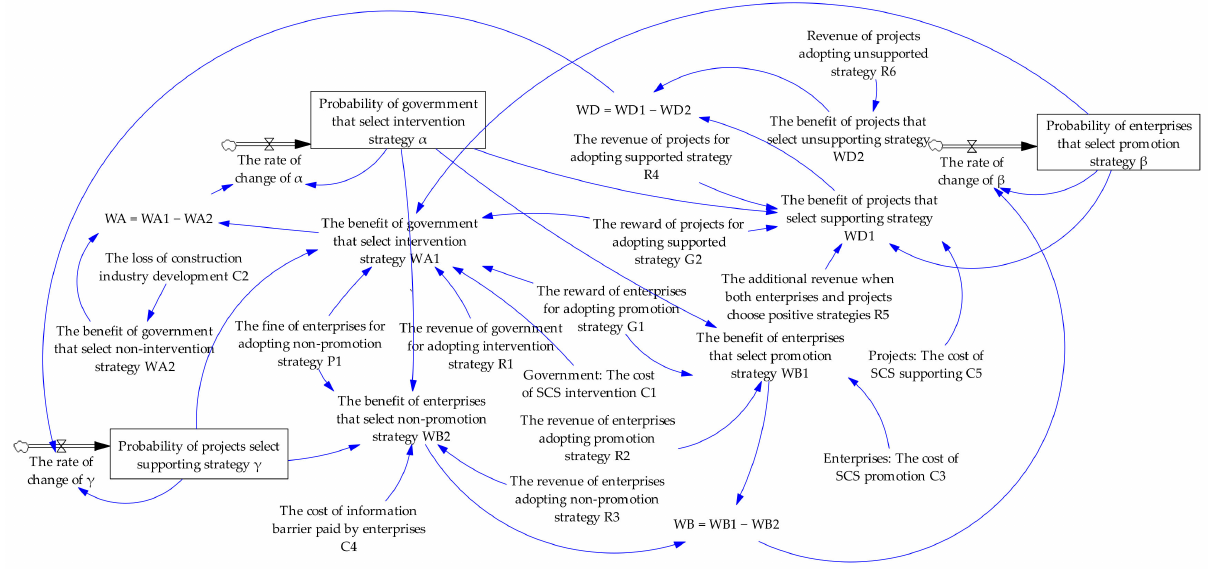
Figure 2. SD evolving a game simulation model for SCS